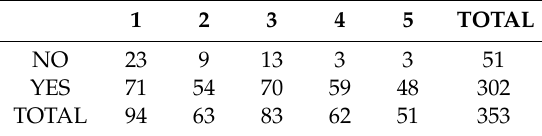
Table 7. Relevance of the cost of publication in the selection of the Open Access journal (1 to 5) compared with the increase in funding, as an initiative measure, in Open Access (YES /